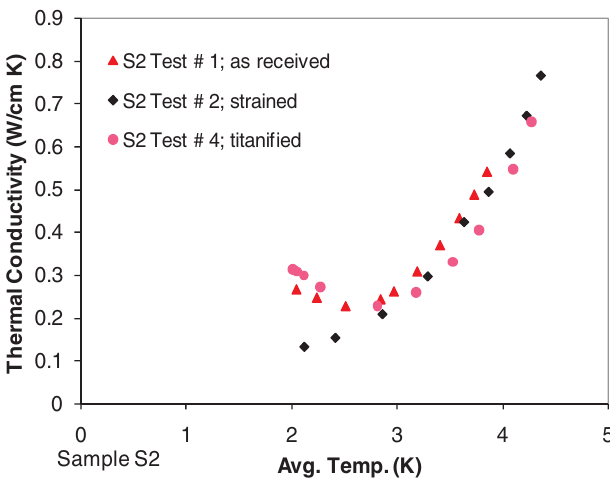
FIG. 11. (Color) Moderate temperature annealing during titani- fication resulted in the reformation of phonon peak (test #4) after it was lost due to inadvertent strains induced (test #3) in the as- received Nb sample S2 (test